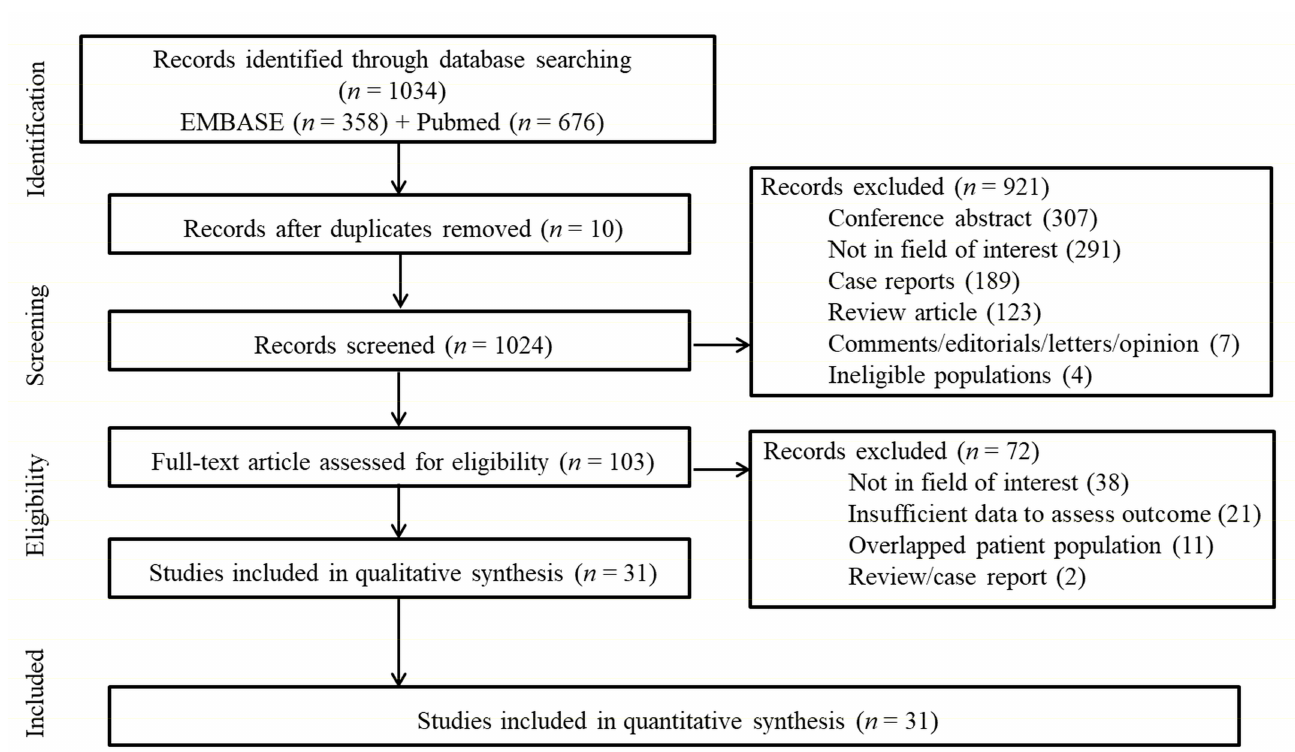
Figure 1. Flow diagram of the included